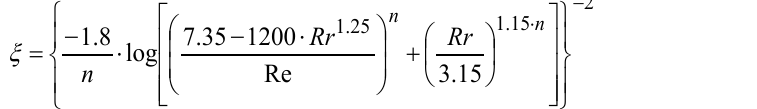
Table 5 Statistical data for modified equations